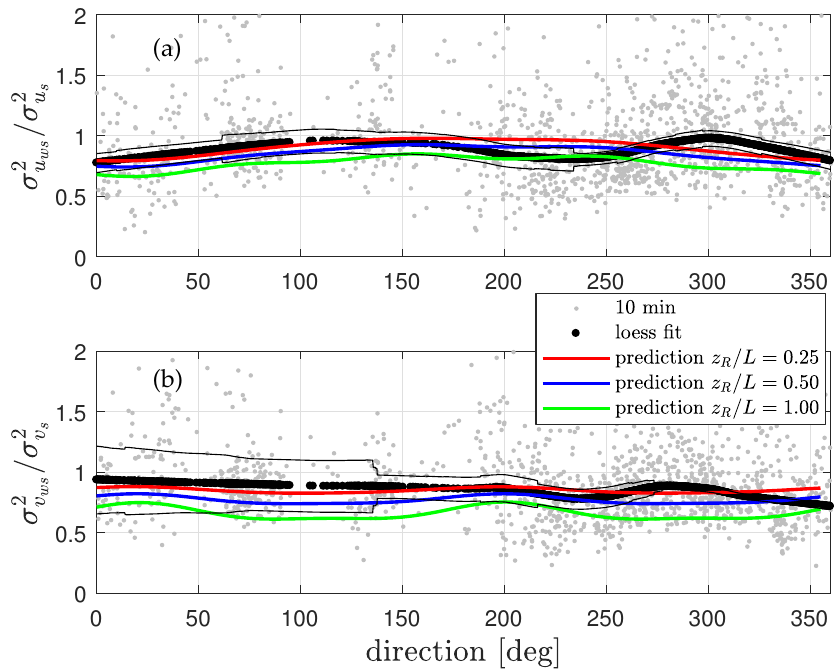
Figure 10. Ratio of the velocity components’ variance of the WindScanners to the sonic anemometer as a function of wind direction. The result for the u - and v -velocity components are shown in frames ( a ) and ( b ), respectively. Measurements and a loess fit to the measurements are shown in markers and predictions in colored solid lines. The standard error of the loess fit is shown in solid black